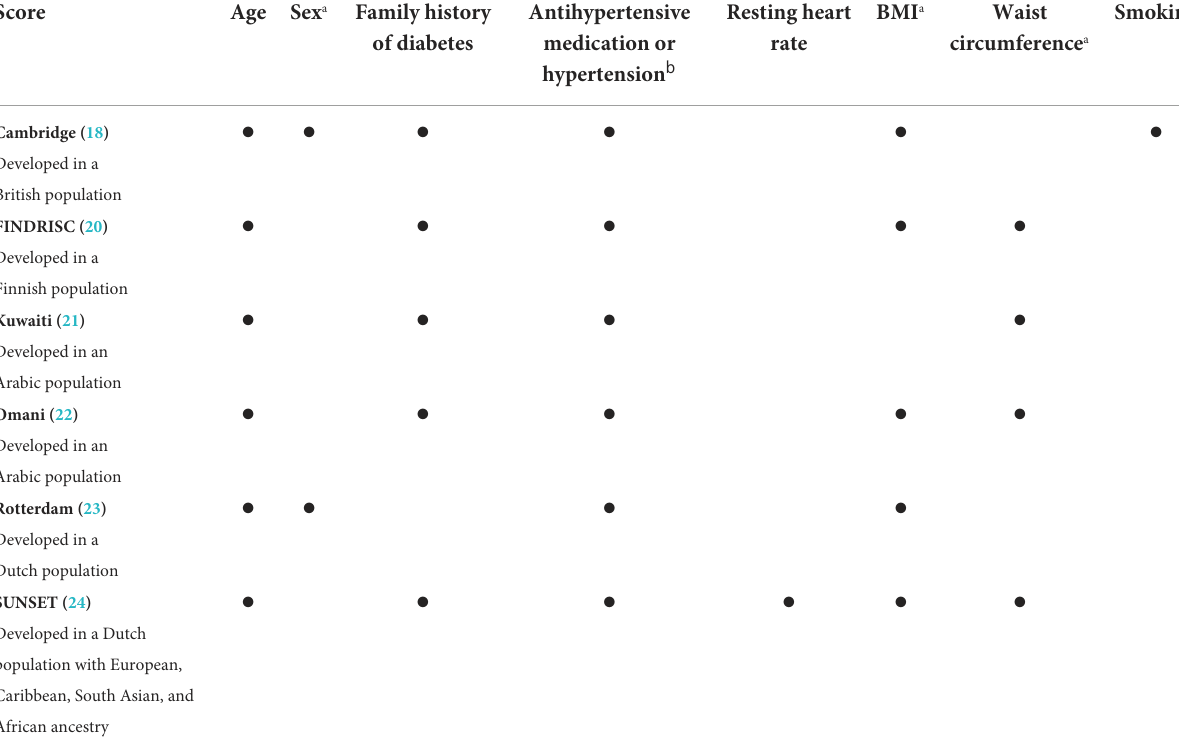
TABLE 1 Components of the diabetes prevalence scores. Score Age Sex a Family history